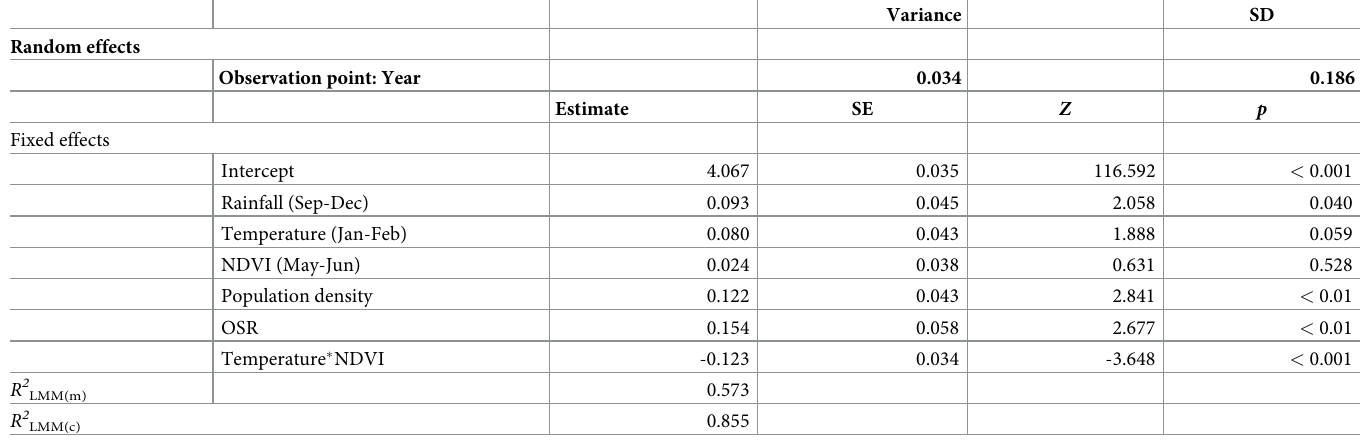
Table 3. Coefficients of the linear mixed-effects model on maximum annual roaring rate. R 2 LMM(m) is the marginal R-squared and R 2 LMM(c) is the conditional R-